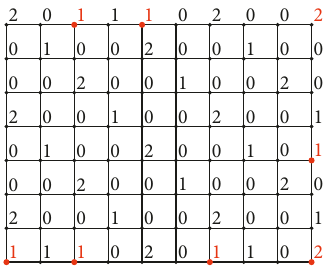
Figure 9: The function f ′ where r � 3 k + 1 , s � 3 l + 2 and r ≡ 4 mod6.